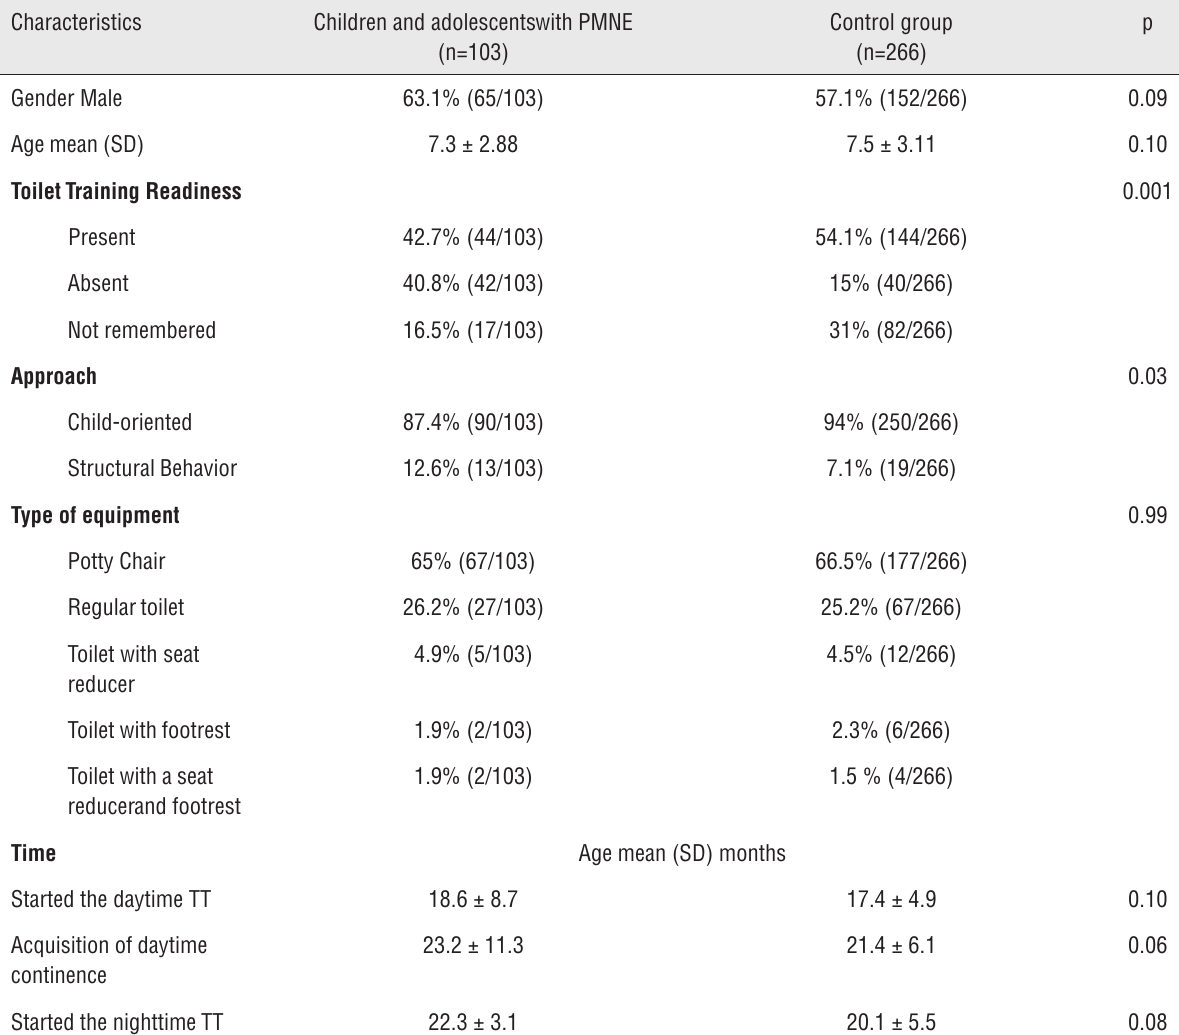
Table 1 - Baselines and characteristics of toilet training in children and adolescents with primary monosymptomatic nocturnal enuresis and the control